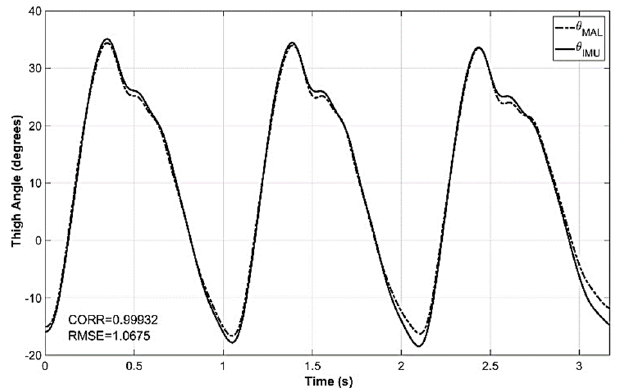
Figure 7. Thigh angle computed from MAL data ( θ MAL ) and IMU data ( θ IMU ) for a sample trial. Correlation coefficient of the two waveforms is 0.99932 and the root mean square error (RMSE) is 1.0675 for this trial. Table 1. Correlation statistics between 𝜃 (cid:3014)(cid:3002)(cid:3013) and 𝜃 (cid:3010)(cid:3014)(cid:3022) .